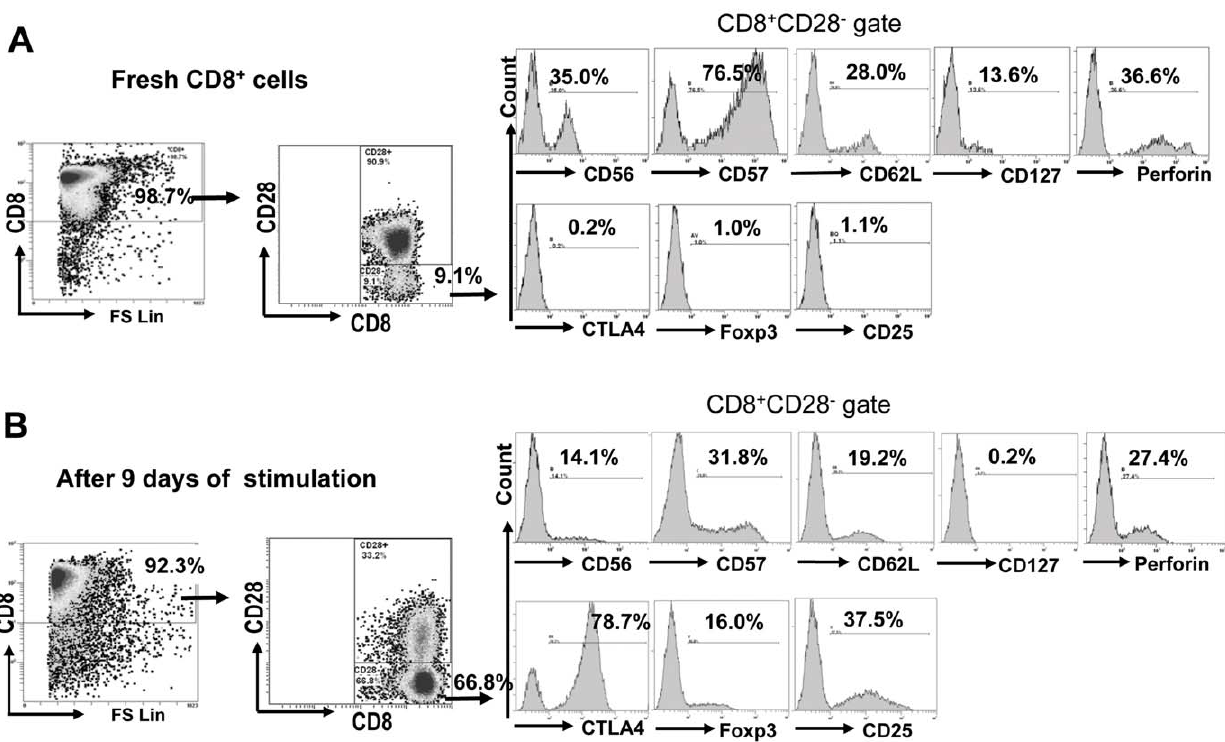
Figure 6. Phenotypic characteristics of the invitro expanded CD8 + CD28 2 T cells. CD8 + T cells freshly isolated from healthy volunteers ( A ) or after in vitro stimulation with donor APCs plus c c cytokines for 9 days ( B ) were analyzed for cell surface or intracellular markers by multichromatic flow cytometry. Date shown are representative of three independent experiments.